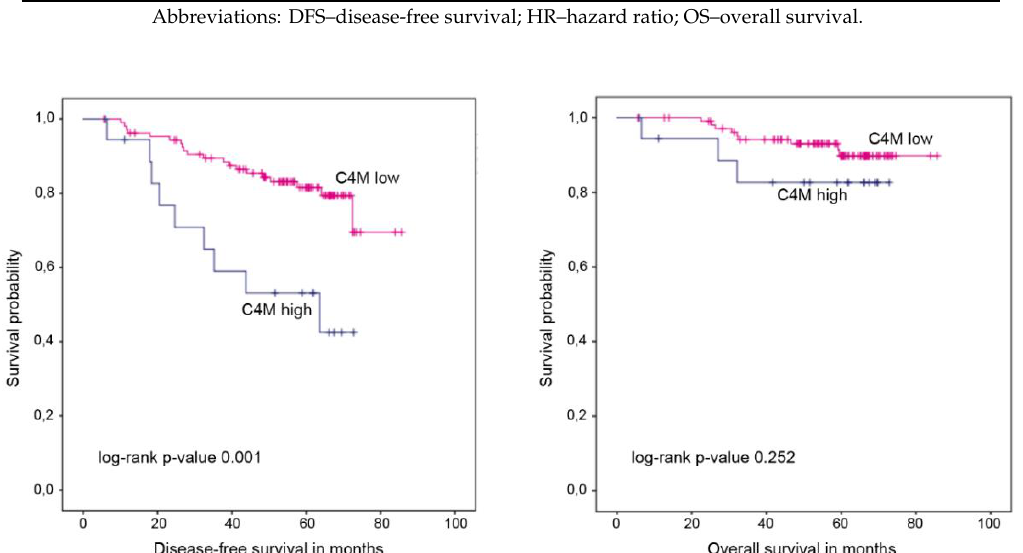
Figure 3. Kaplan–Meier plots of disease-free and overall survival stratified by C3M levels at baseline.